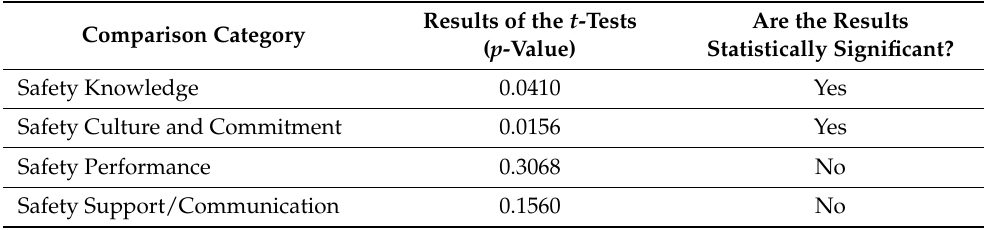
Figure 7. Workers’ safety evaluation.